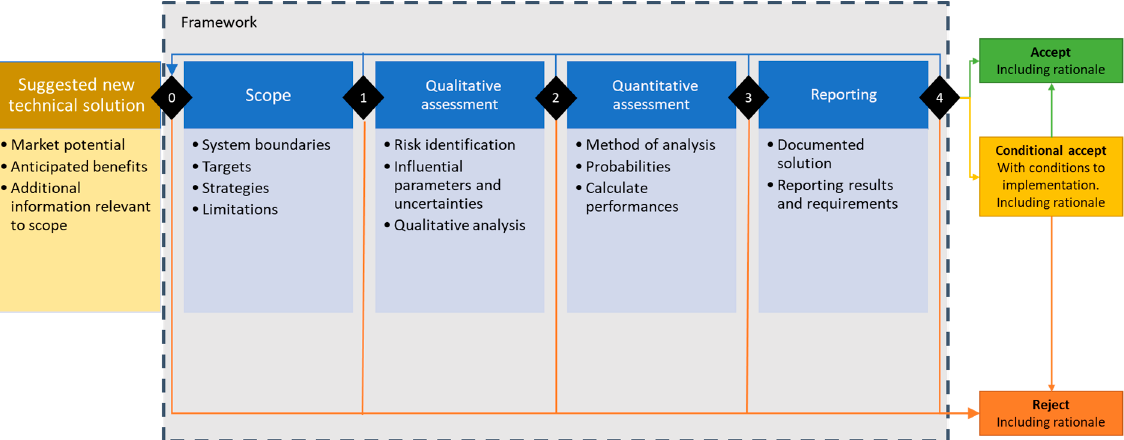
Figure 1. Workflow, as suggested in [6], and adapted from IEA Annex 55 [7,8]. Steps in the framework can be iterated as the work proceeds. Suggested tollgate decisions are 0: to initiate assessment, 1: to accept scope, 2, 3: to proceed with assessment and 4: to proceed to implementation. Decision can be to proceed, to revise, or not to proceed. Reprinted from [6].